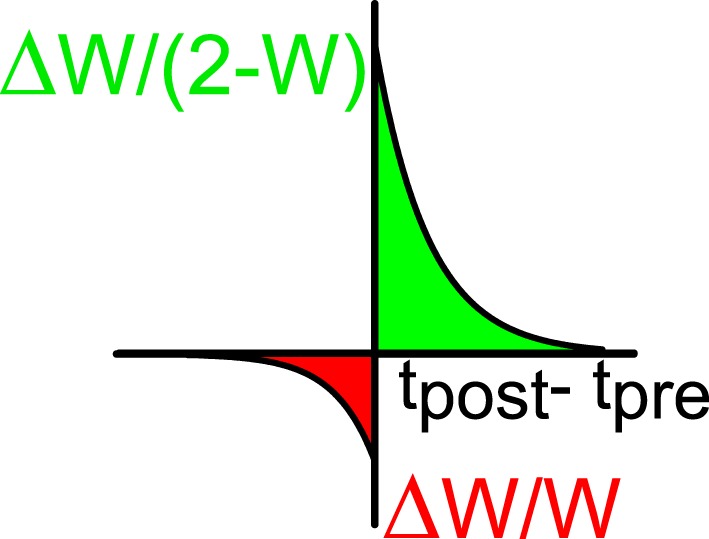
STDP window: the relative changes of synaptic efficacy depend on the time difference between the post-synaptic (tpost) and the pre-synaptic (tpre) spikes. Green indicates facilitation and red depression.